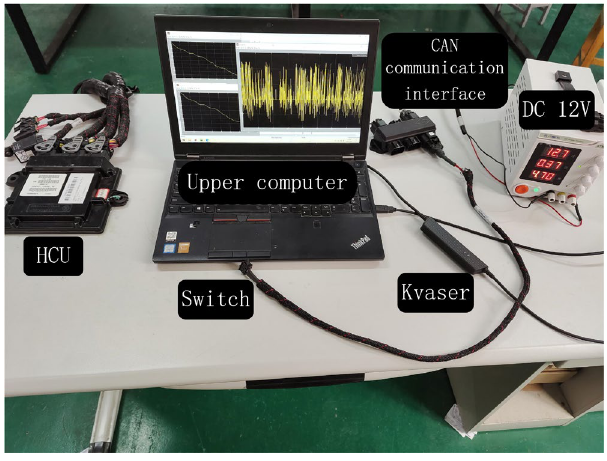
Figure 17. The HIL test system.